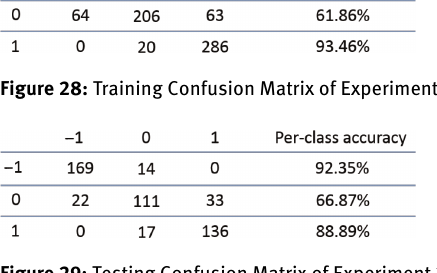
Figure 29: Testing Confusion Matrix of Experiment